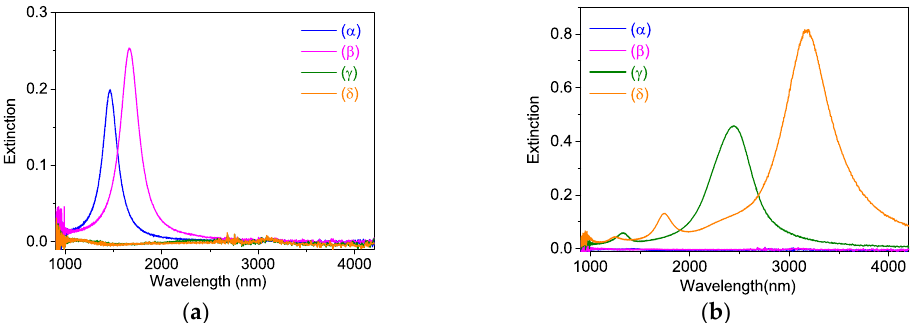
Figure 3. Extinction spectra of straight nanorods with ( a ) x - and ( b ) y -direction polarized illumination.